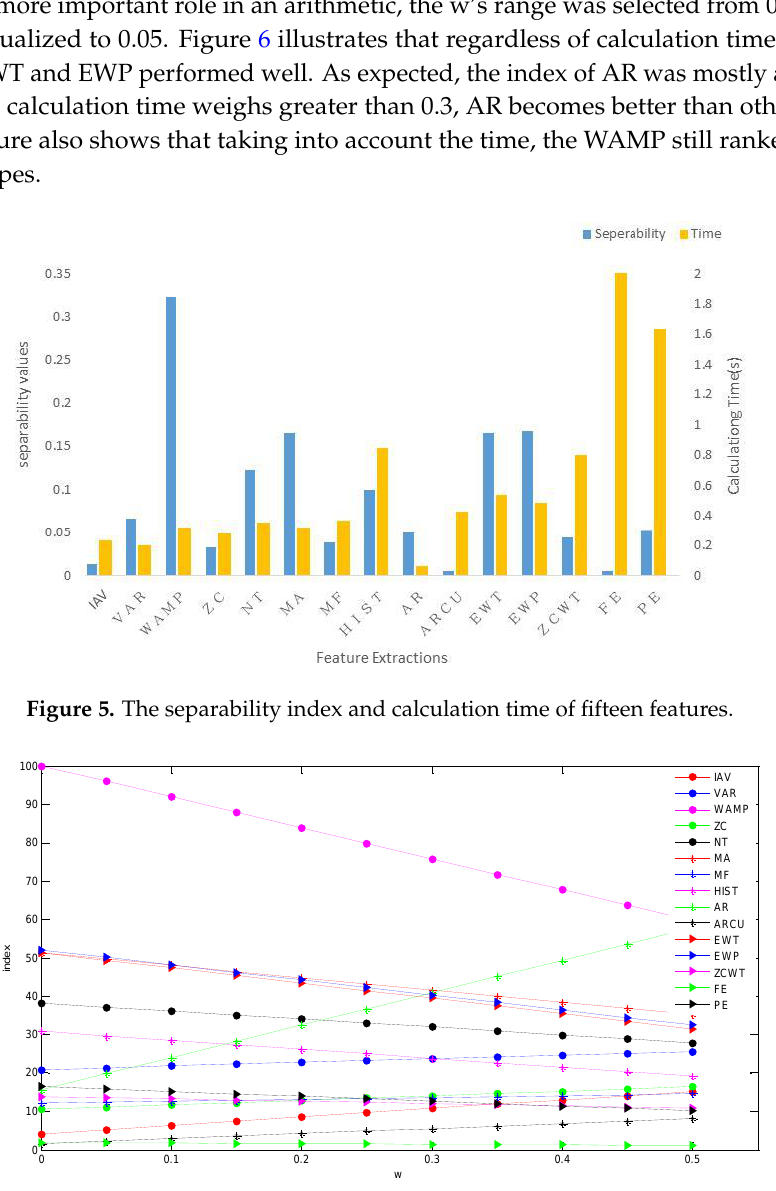
Figure 6. The value of the performance index with various w values.